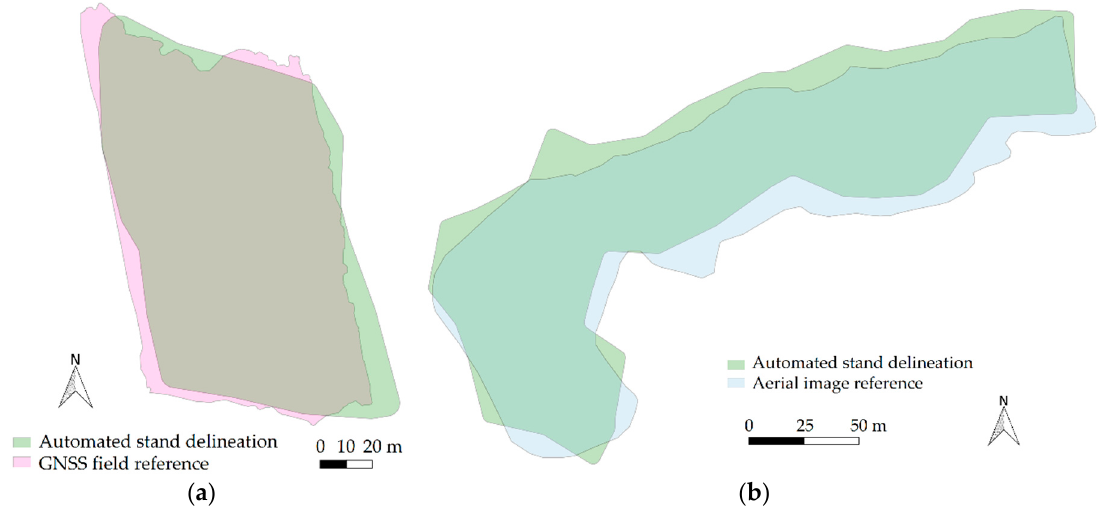
Figure 13. Examples of shifted harvested stands. The ETRS-TM35FIN (EPSG:3067) coordinate system is used in the figure. ( a ) The stand has shifted towards east with respect to the GNSS reference. ( b ) The stand has shifted towards northwest with respect to the aerial image reference.